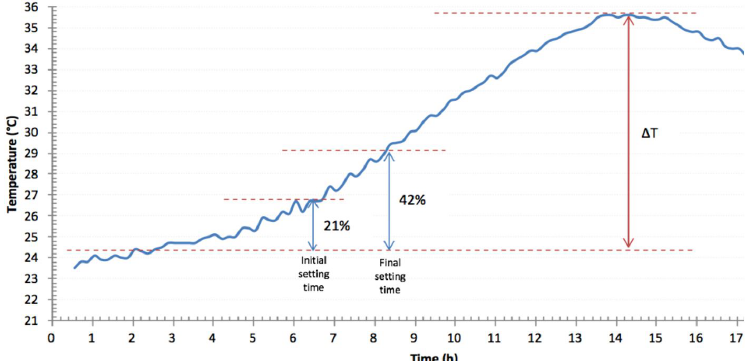
Figure 5. Scheme representing the determination of the initial and final setting times by the direct fraction method.